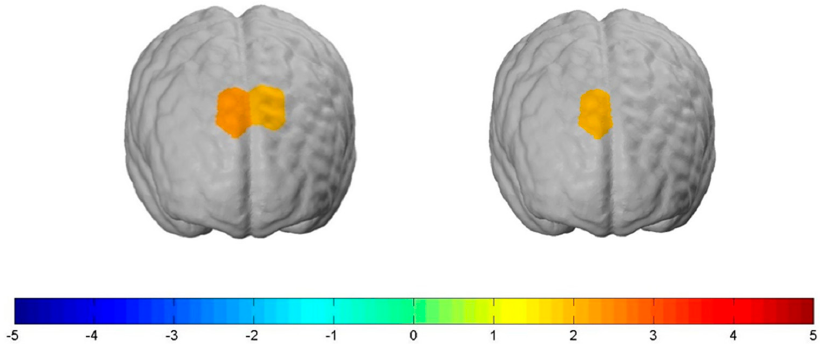
Figure 7. Contrast of the NormalBMI group (n = 56) with the HighBMI group (n = 22) for the two experimental conditions. The participants with a normal BMI showed significantly increased prefrontal cortex activation compared to the ones with a high BMI in both experimental conditions. Left brain: For the NormalBMI group, neural activity in the dlPFC increased when exposed to the “Stop” condition. Right brain: For the NormalBMI group, neural activity in the dlPFC increased when exposed to the “Shock” condition.